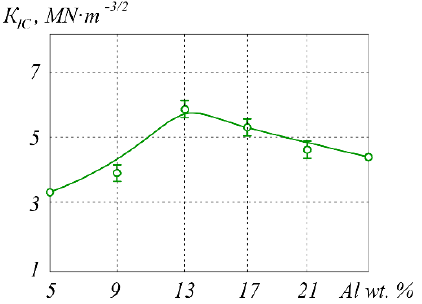
Figure 12. Fracture toughness of cermet samples sintered from initial powders of Cr 2 O 3 + Al with different proportions of aluminum at Т = 1600 °С under Р = 30 MPA for t = 10 min.